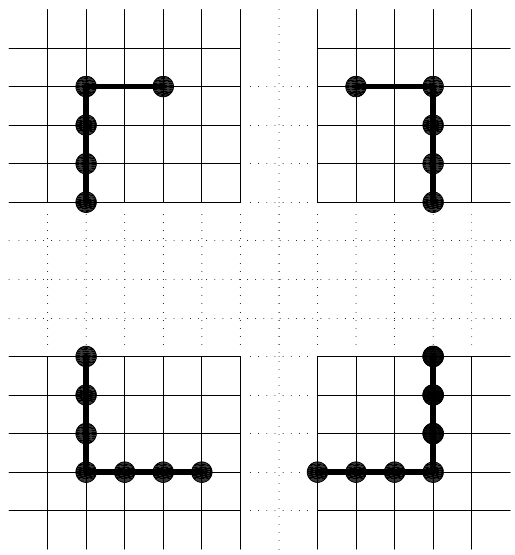
Figure 3. The structure of the skeleton drawing.